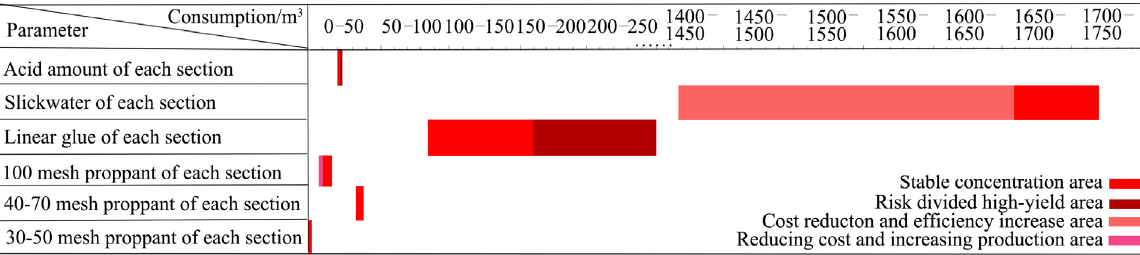
Figure 10. Optimal area range of fracturing construction parameters.